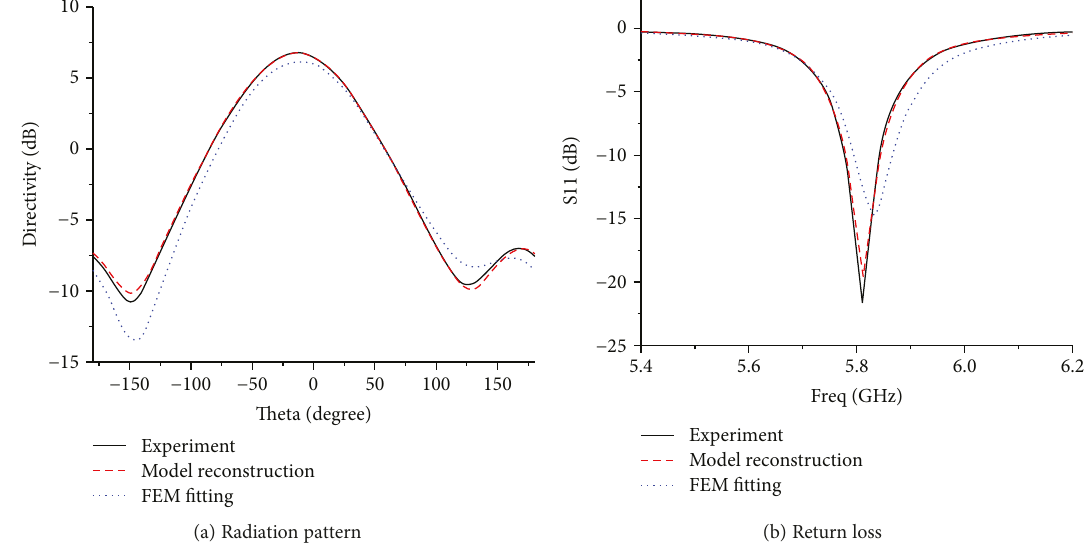
Figure 11: Electrical performance